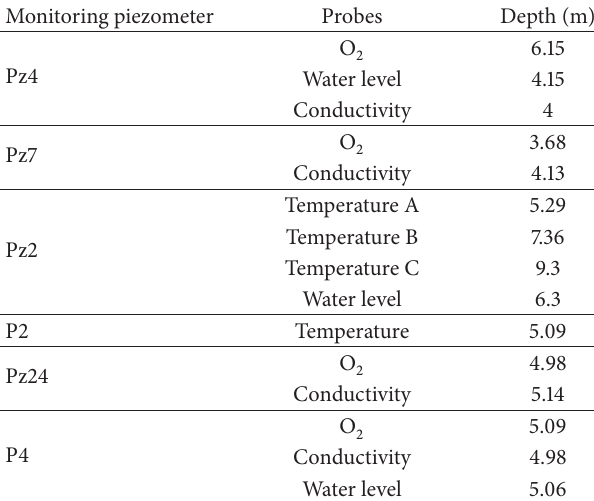
Table 1: List of probes in the monitoring piezometers (function and depth).